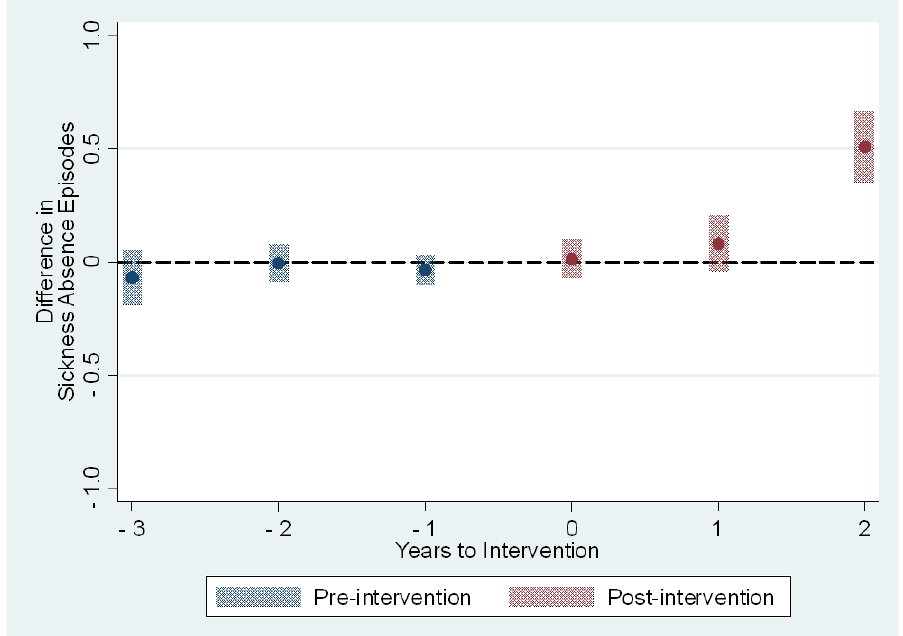
Figure 2. The estimated dynamic average treatment effects of the use of the participatory scheduling tool on sickness absence episodes from all sickness absences. Event study estimates with 95% con- fidence intervals depict difference in outcome measure between intervention and control groups relative to timing of the intervention. Year 0 is the first full year of the intervention.